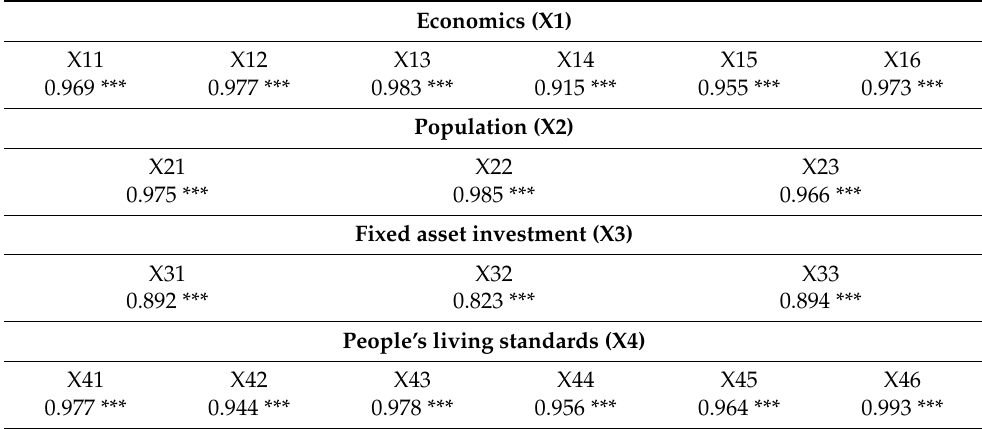
Table 3. Correlation between urban land area and socio-economic driving